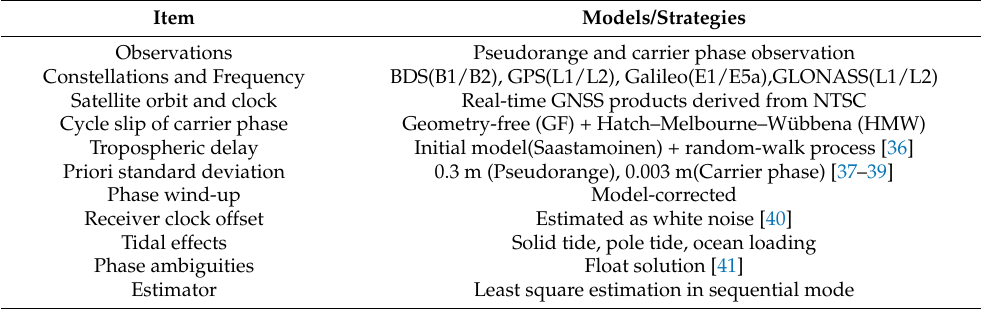
Table 1. The models and strategies adopted in the real-time GNSS prototype system.